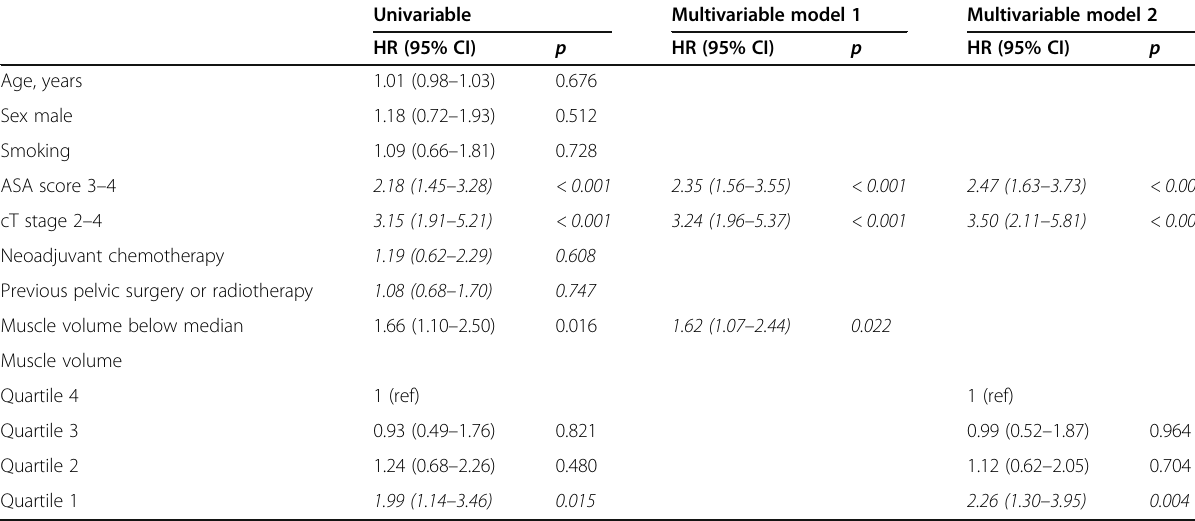
Table 2 Cox regression analysis for overall survival with a restricted 2-year follow-up